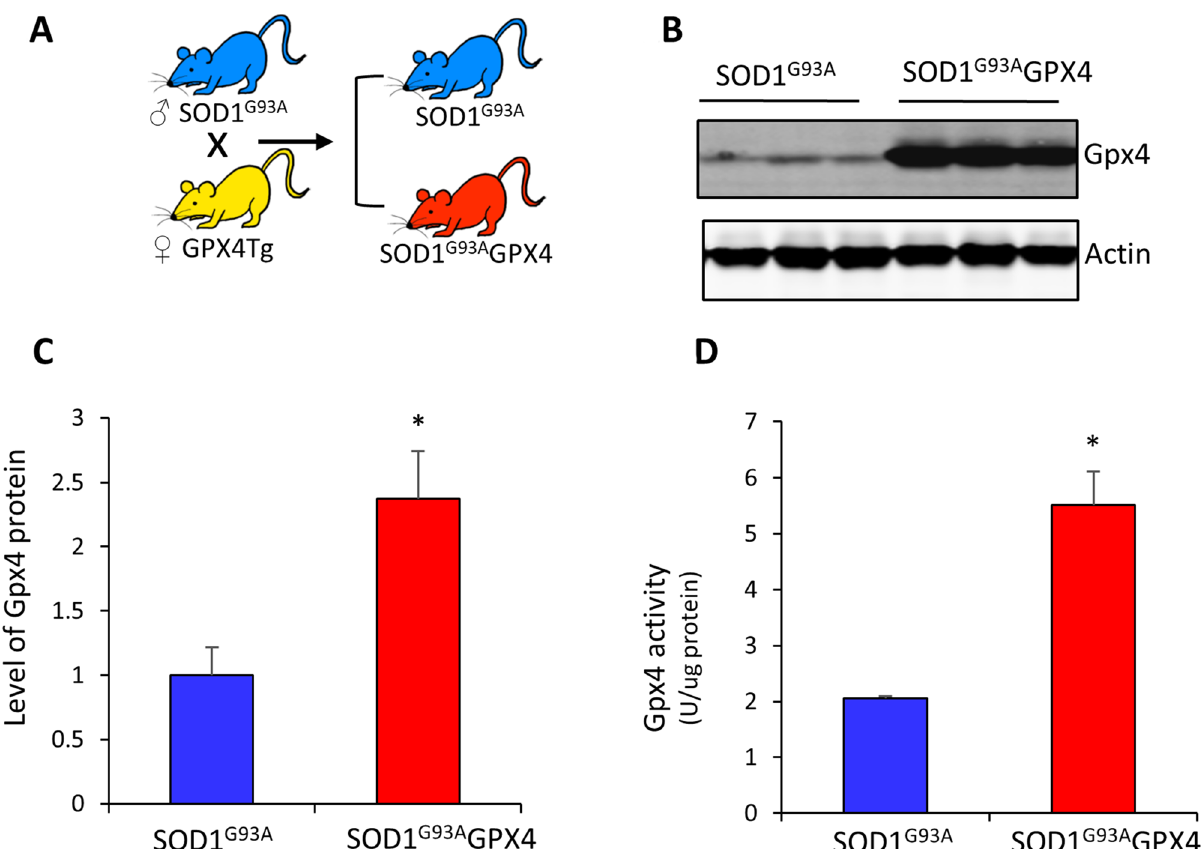
Figure 1. Overexpression of Gpx4 in SOD1 G93A GPX4 mice. ( A ) Graph of breeding strategy. ( B ) Graph of western blots showing Gpx4 protein in spinal cord tissues of SOD1 G93A and SOD1 G93A GPX4 mice at 60 days of age. ( C ) Quantified results of western blots showing an increased level of Gpx4 protein in SOD1 G93A GPX4 mice. n = 3 (biological repeats) for both genotypes. ( D ) Gpx4 activities in spinal protein extracts of SOD1 G93A mice and SOD1 G93A GPX4 mice. n = 6 (biological repeats) for both genotypes. *: p <